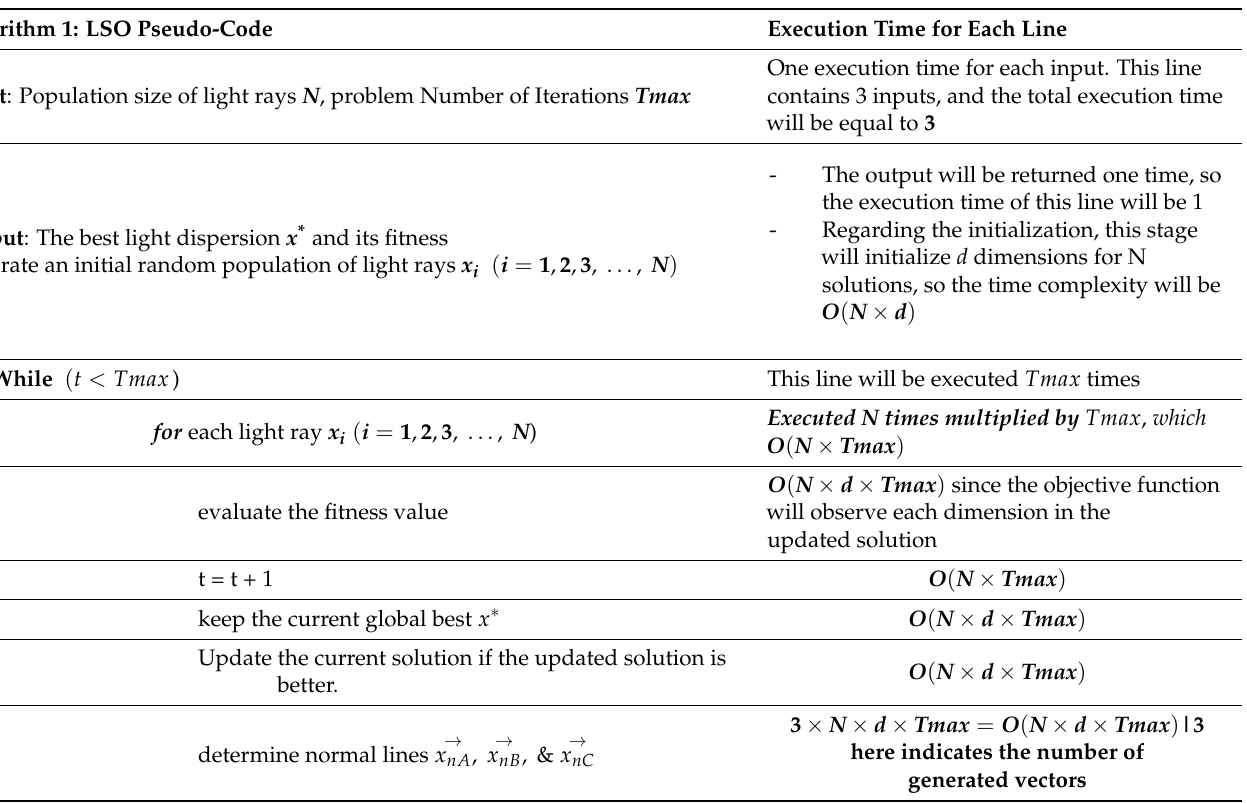
Table 3. Execution time of each line in the proposed algorithm according to using the asymptotic